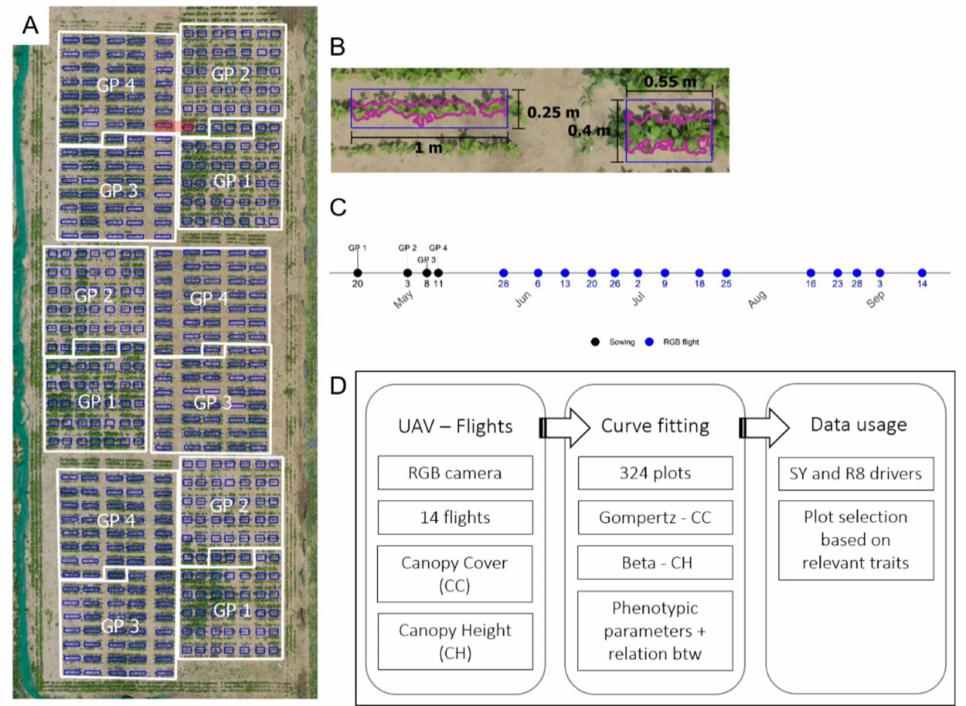
Figure 1. Schematic overview of ( a ) the trial with group locations (white boxes, GP1-4), ( b ) zoom of two plots, marked by a red box in A, with the mask applied to the images to select pixels corresponding to vegetation, ( c ) timeline of the sowing dates (per GP) and UAV flights and ( d ) workflow followed in the